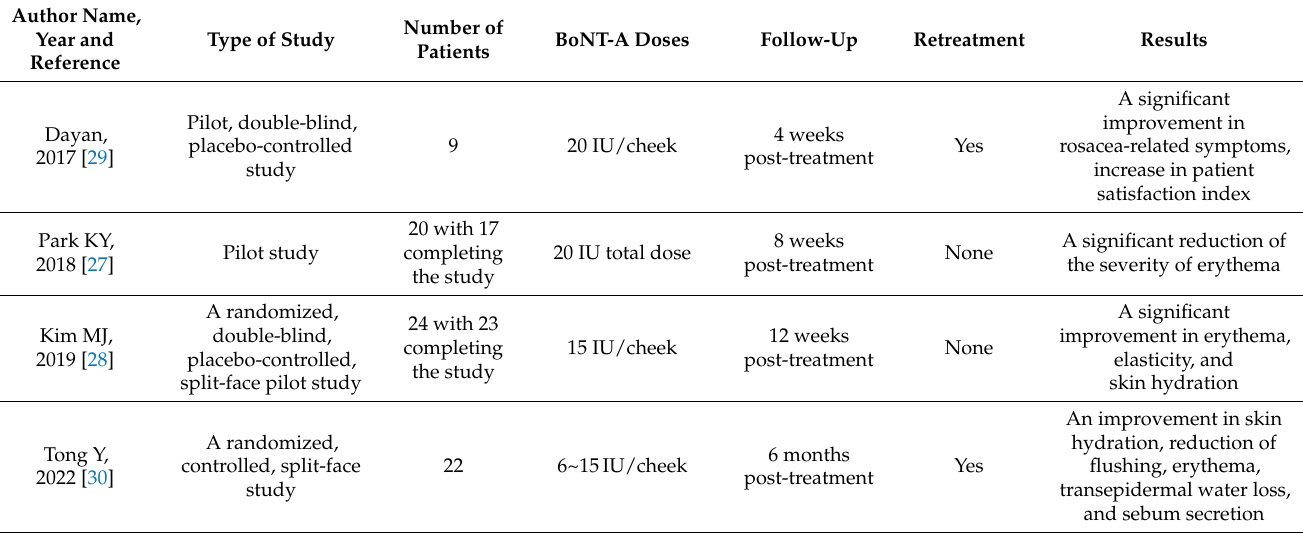
Table 2. BoNT-A in